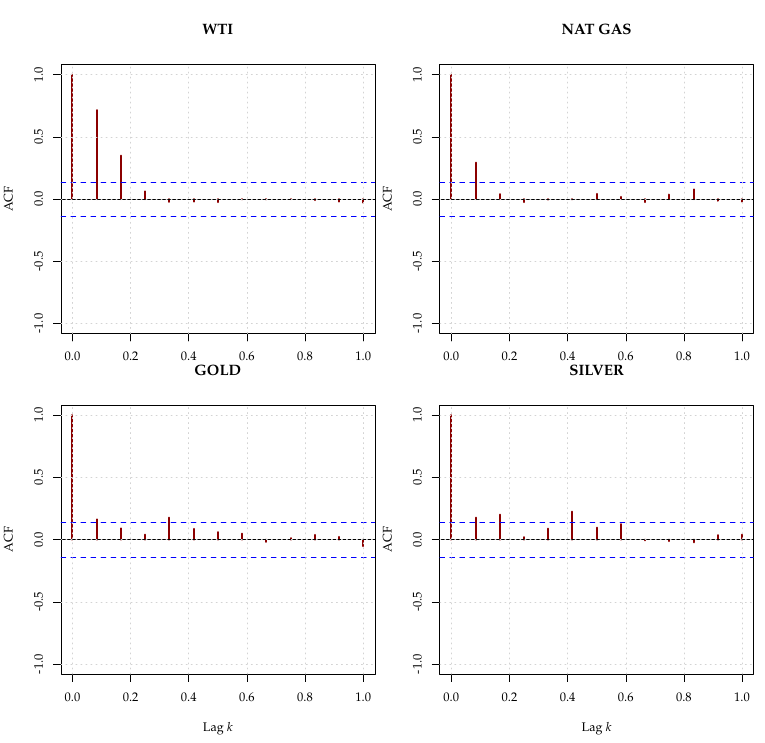
Figure 18. Sample correlograms for the squared series of the four commodities up to one year. The confidence bands at level 99% under the white noise hypothesis are indicated as blue dashed horizontal lines.